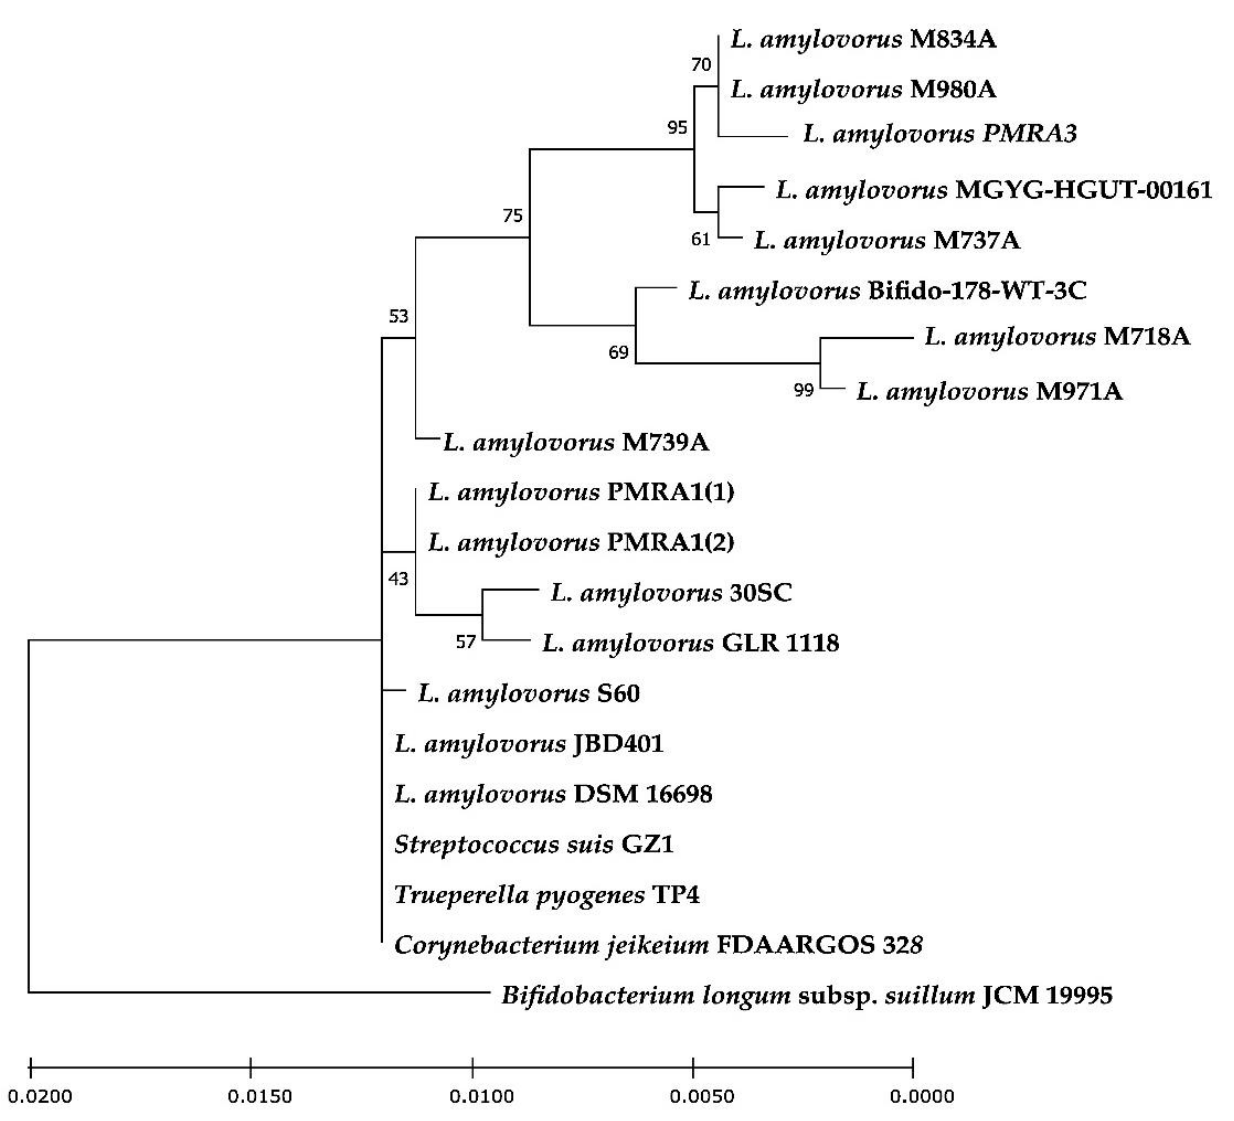
Figure 1. The phylogenetic tree of a tetW gene, showing the relationship between the tetW genes from L. amylovorus (received from our study and NCBI) and the tetW sequences of selected bacterial species showing the highest similarity to L. amylovorus tetW genes (based on the blastn analysis). The evolutionary history was inferred using the Maximum Likelihood method and the Tamura 3-parameter model [36]. Bootstrap values (1000 replicates) were applied and the percentage of trees in which the associated taxa clustered together is shown next to the branches. The tree is drawn to scale, with branch lengths measured in the number of substitutions per site. There were a total of 1932 positions in the final dataset. The phylogenetic tree was rooted with the tetW from Bifidobacterium longum subsp. suillum JCM 19995 as an outgroup. Evolutionary analyses were conducted in MEGA X [34].